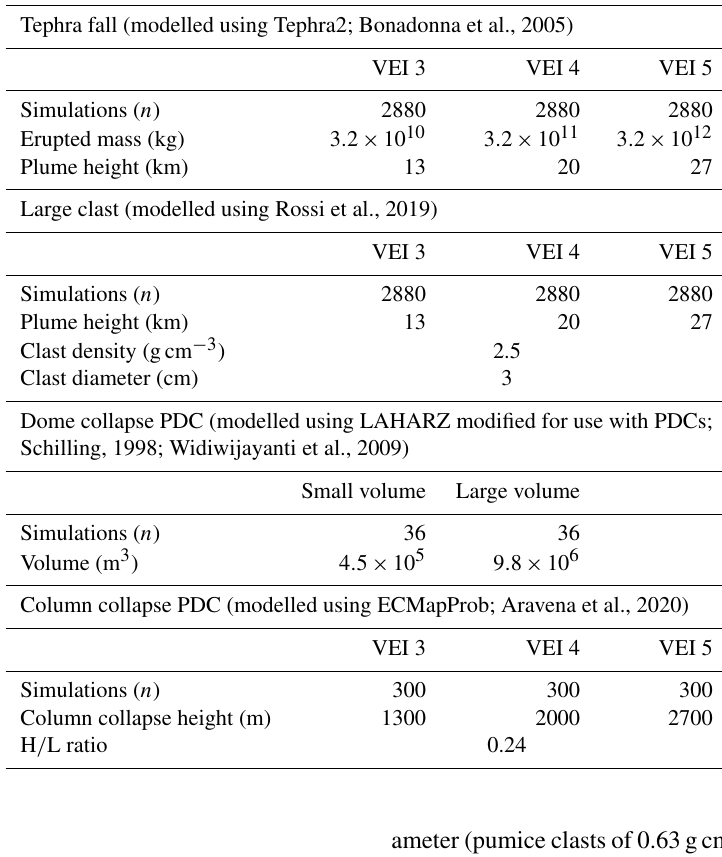
Table 3. Key model input parameters used for the four hazards, with more details and rationale provided in the subsections below and Appendix